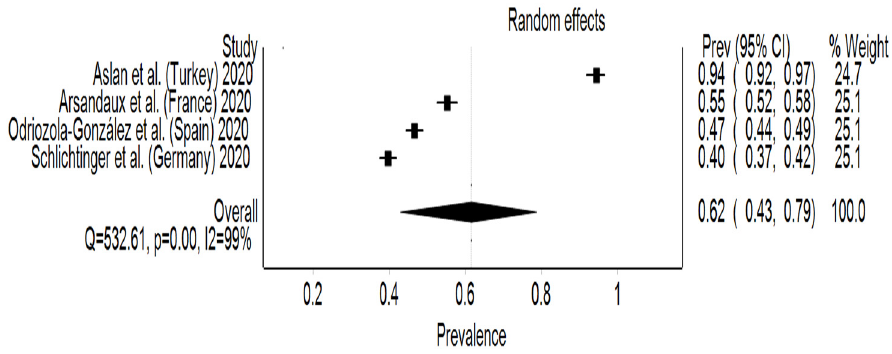
Figure 6. Forest plot of studies and their prevalence rates on